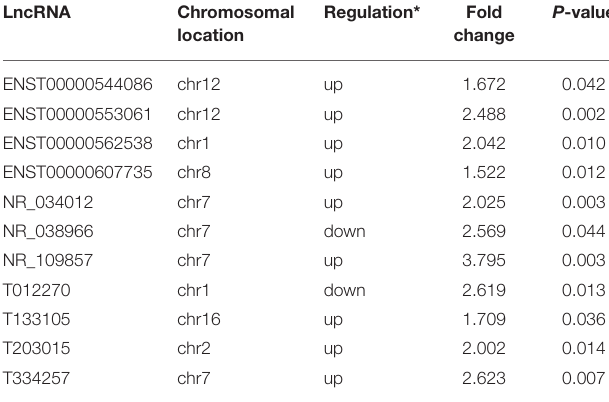
TABLE 4 | The 59 differentially expressed lncRNAs in the co-expression network.